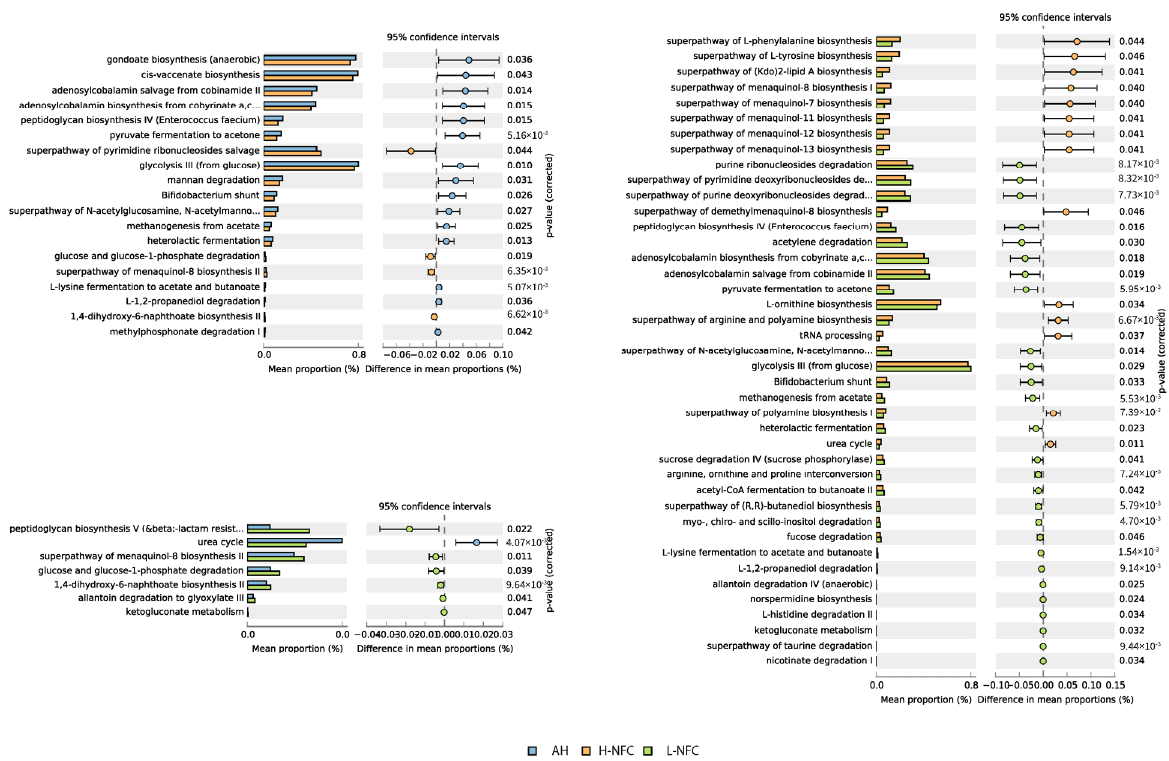
Figure 7. Predicted metagenomic difference between alfalfa based diet (AH) and a CS based diet with high NFC (H-NFC); AH and CS based diet with low NFC (L-NFC); H-NFC and L-NFC. Pathways were sorted in descending order based on the affecting factor.